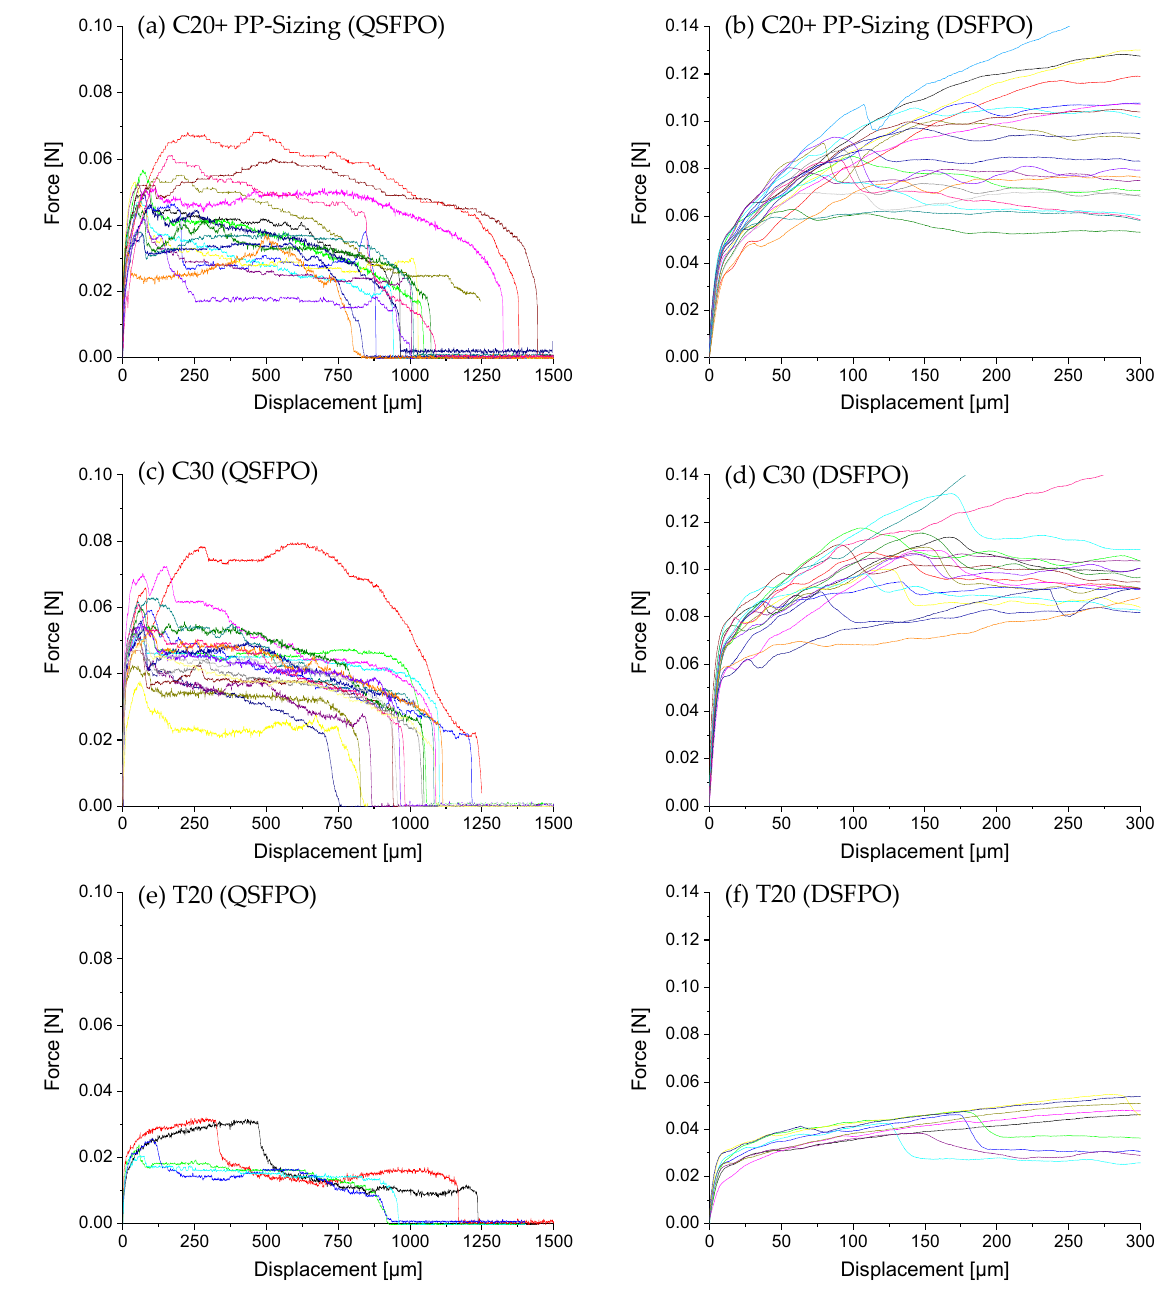
Figure 10. Quasi-static (left) and dynamic (right) SFPO force–displacement curves of ( a , b ) C20+ fibers with additionally applied PP sizing dried at 60 °C; ( c , d ) C30 fibers and ( e , f ) trilobal T20 fibers pulled out of the high-strength matrix. Note the different axes’ limits. Color lines indicate different test samples.